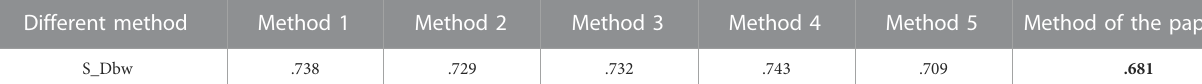
TABLE 6 Assessment of cluster results.